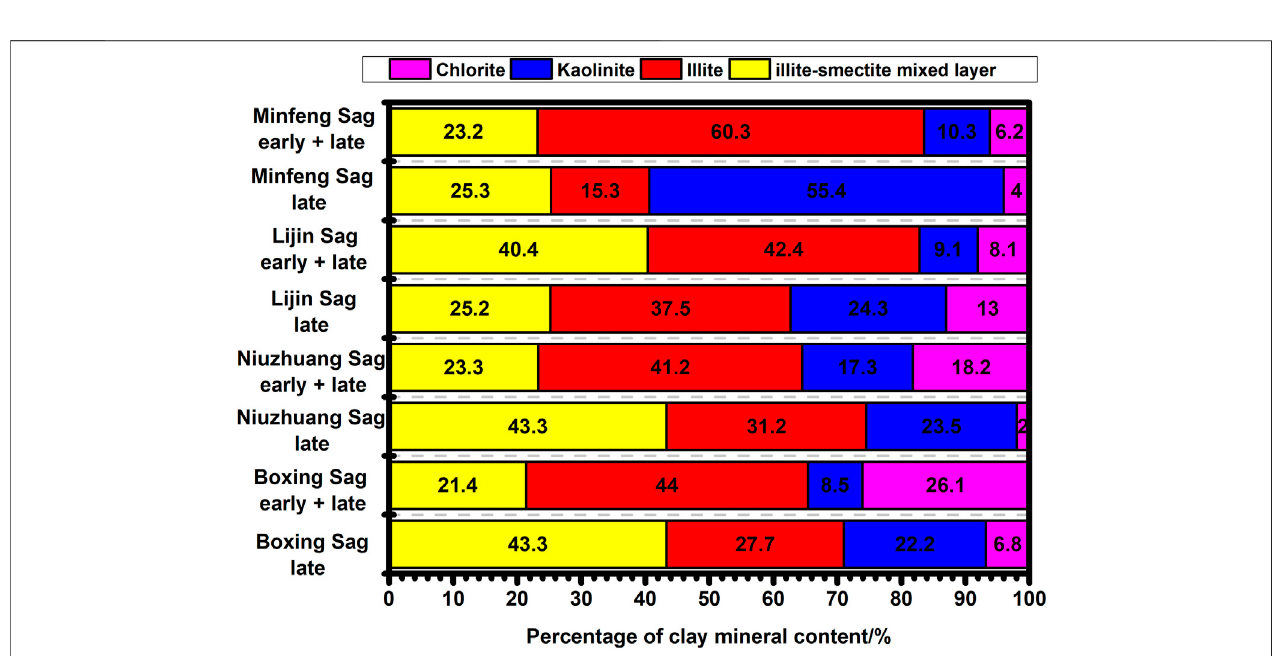
FIGURE6| Comparisonofclaymineralscontentsbetweenreservoirwiththetwohydrocarbonaccumulationstagesandthereservoirwiththeonelatestageinthe Dongying